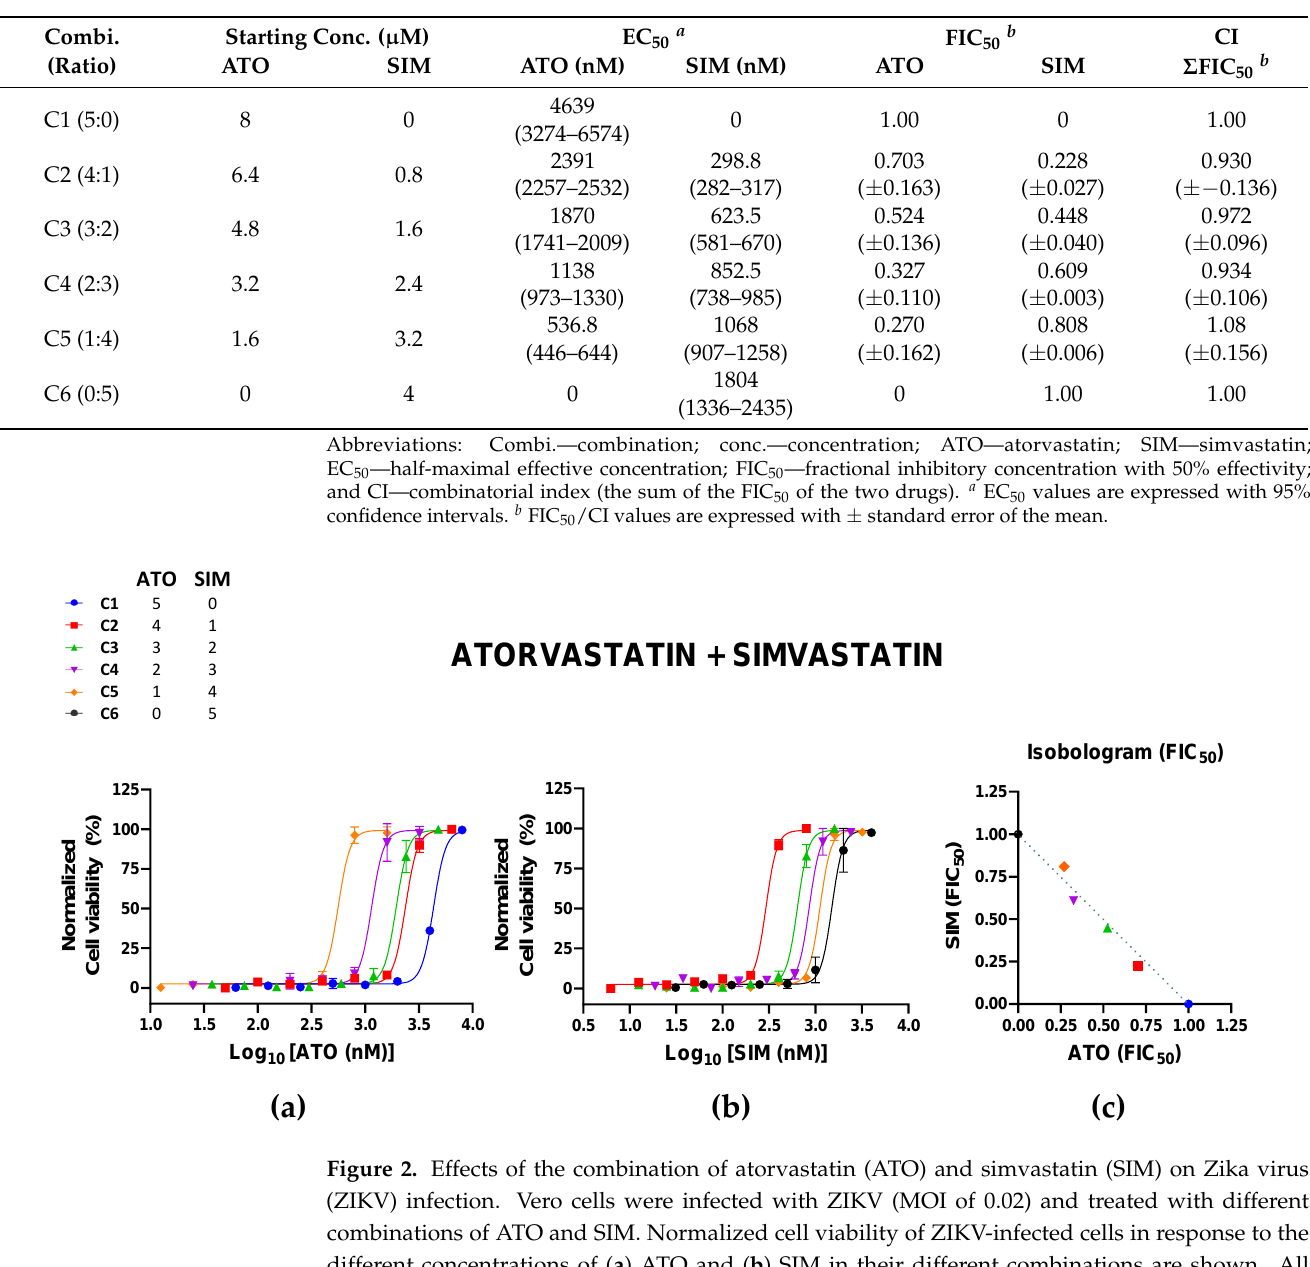
Table 2. Half-maximal inhibitory concentrations of the atorvastatin and simvastatin combinations. Combi.